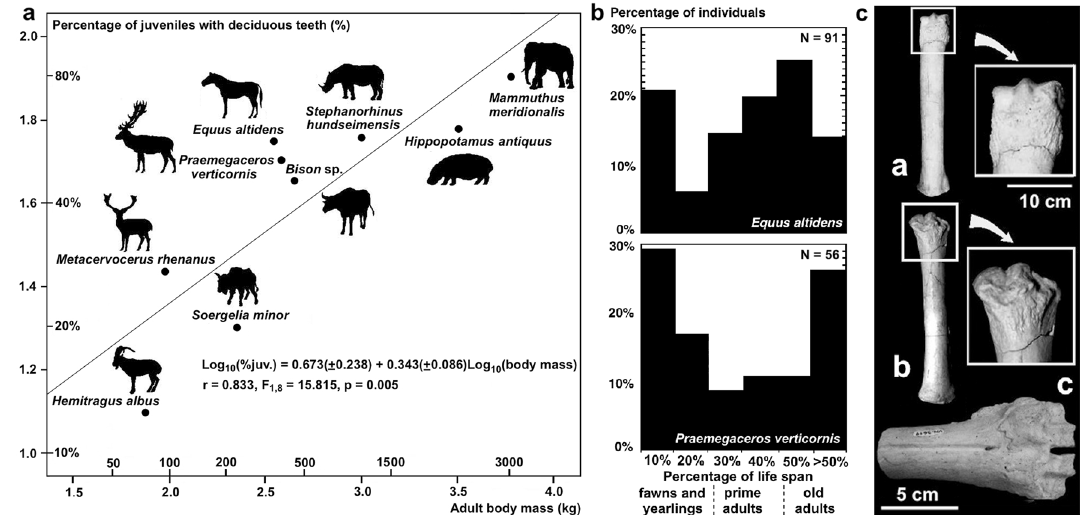
Figure 2. Evidence of prey selection in VM3. ( a ) Least-squares regression between the logarithms of the mean body masses (X-axis) of adult individuals of the herbivore species of Venta Micena, estimated from postcranial measurements (data from Refs. 6,14 ), and the logarithms of the percentage of calves and juvenile individuals over the MNI estimates of each species (Y-axis), calculated from teeth counts (data from Table 1). ( b ) Mortality profiles deduced from crown height measurements in horse Equus altidens and megacerine deer Praemegaceros verticornis (updated from Ref. 6 ). ( c ) Three examples of osteopathologies detected in VM3 (( a ) horse metatarsal with osteophytic overgrowths in the distal epiphysis; ( b ) horse metacarpal showing an intense deformation of the distal epiphysis; ( c ) severe osteoarthritis in a third-four metacarpal of megacerine